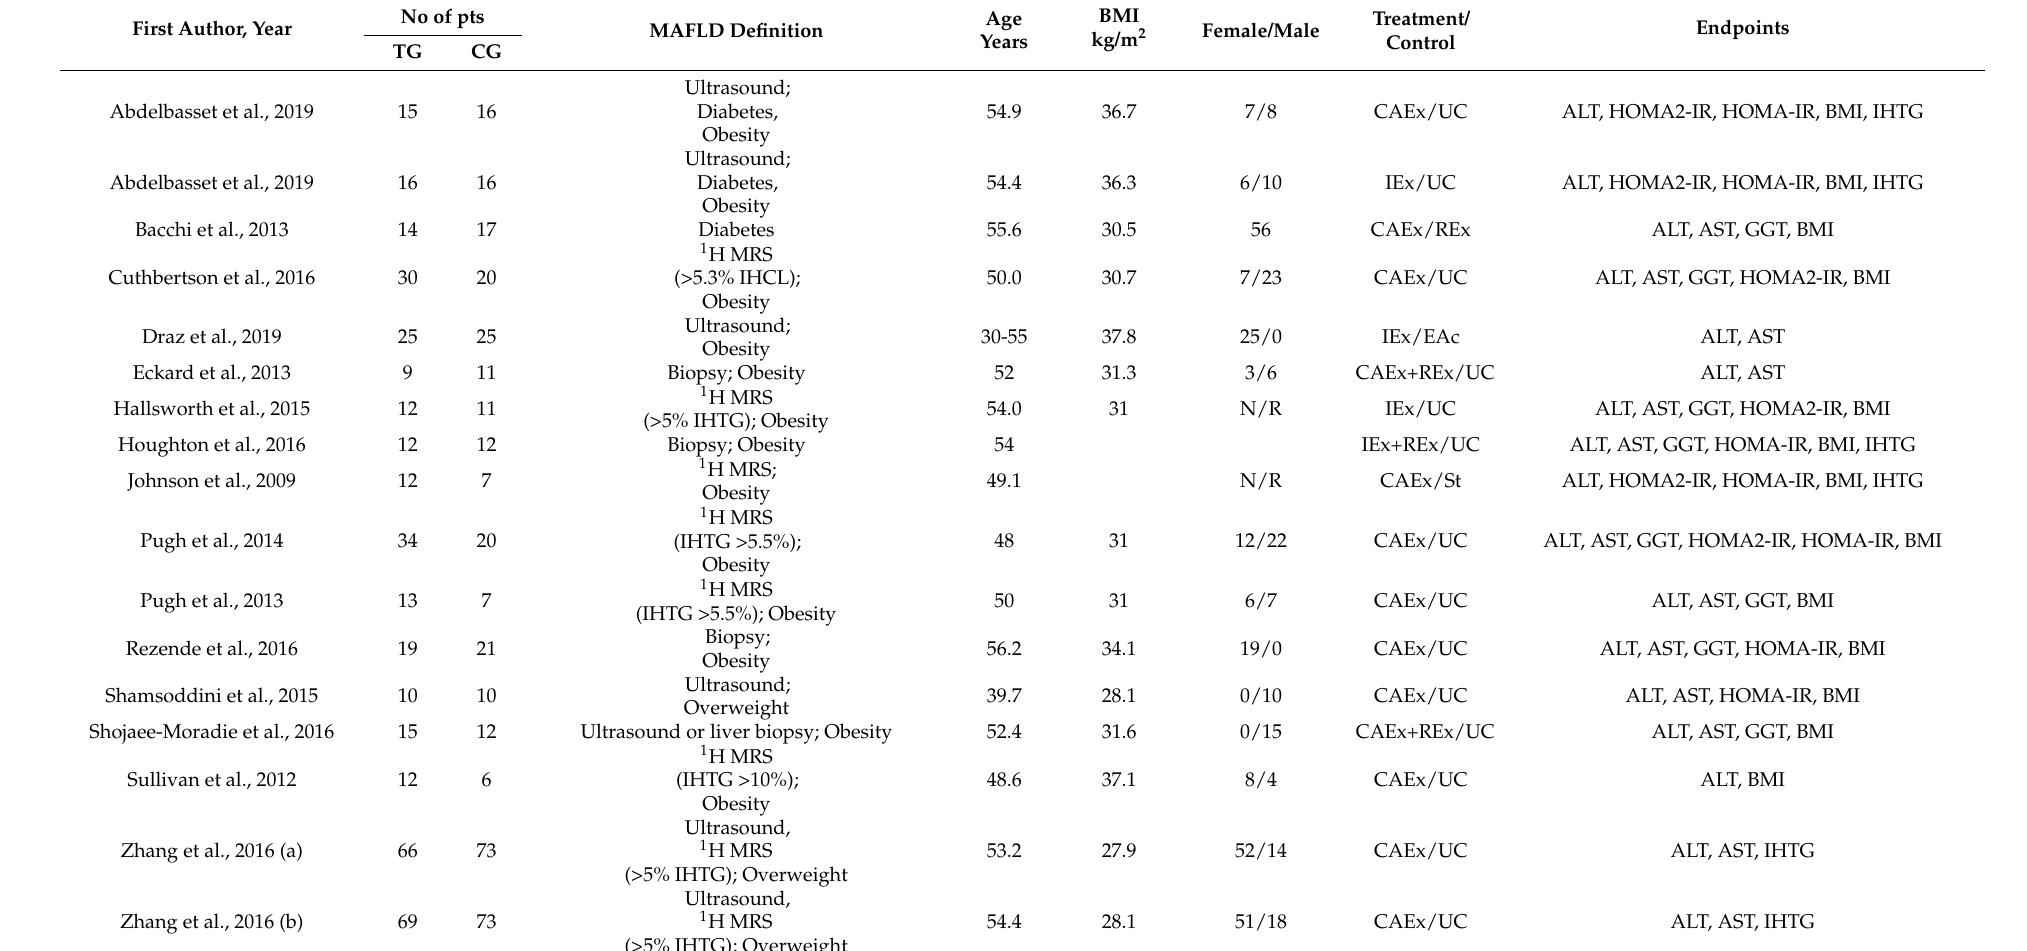
Table 2. Details of included